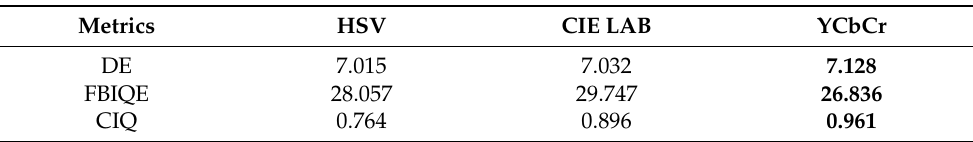
Table 2. Performance comparison among the HSV, CIE LAB, and YCbCr color spaces with the proposed method.